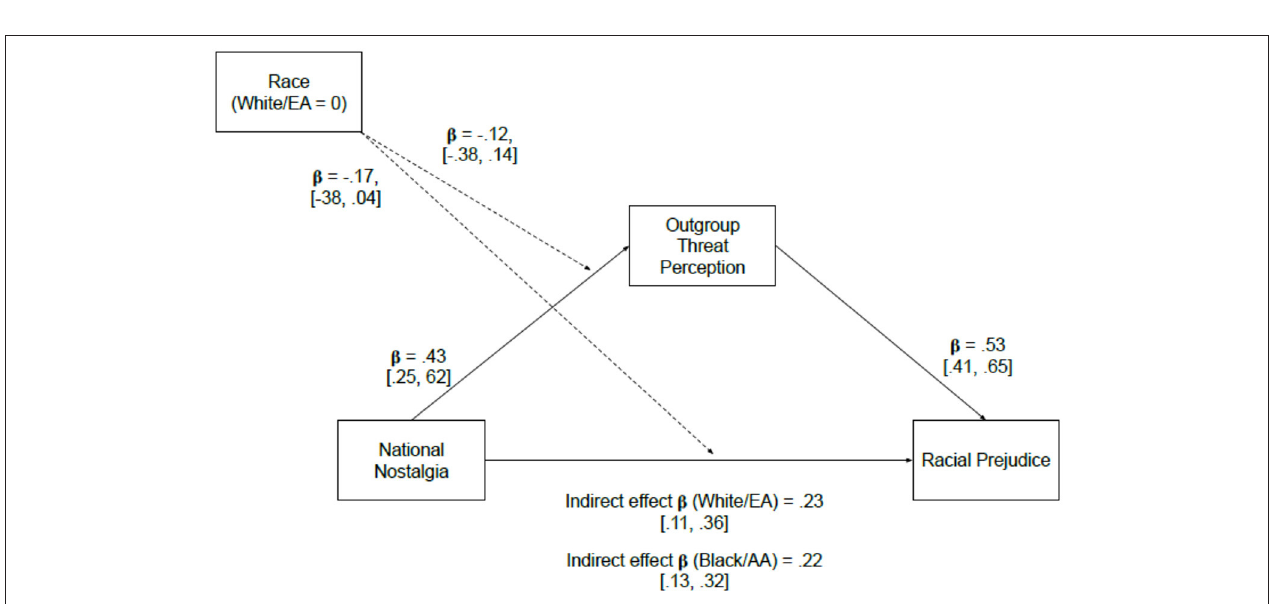
FIGURE 6 | Mediation of national nostalgia relationship with racial prejudice by outgroup threat perception, moderated by participant race.